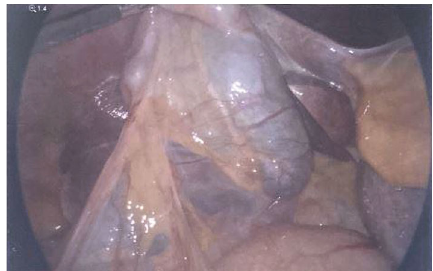
Figure 3: Intraoperative picture with one peritoneal lining.